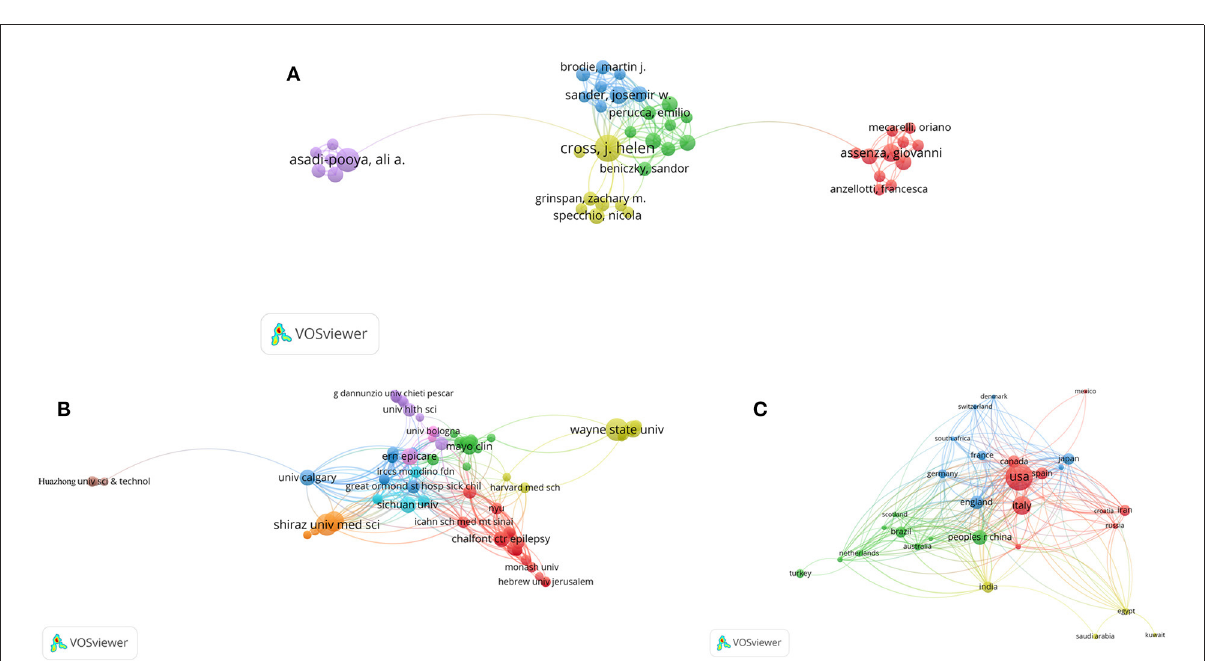
FIGURE3 Network visualization of co-authorship analysis of COVID-19 and epilepsy research. Network visualization of (A) authors, (B) organizations, and (C) countries in the research field. The sizes of the points represent co-authorship frequency. The line between two points indicates that